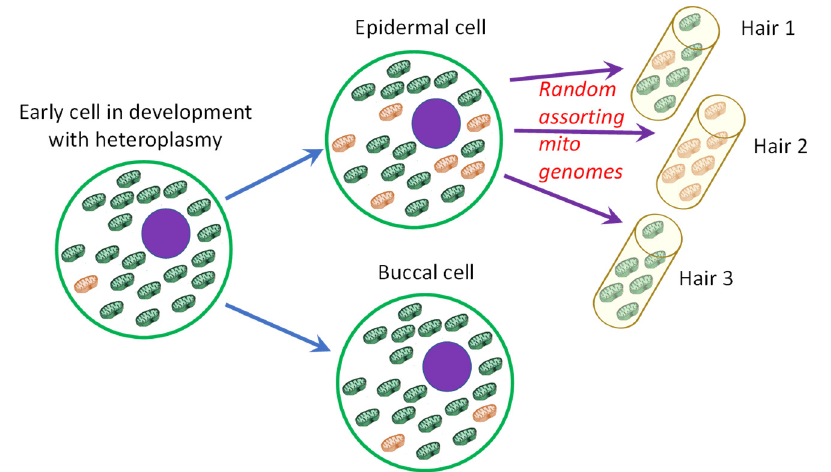
Figure 1. Illustration of shifts in heteroplasmy (HP) levels. Levels of HP can change during development. Especially for hairs, random assorting of mitochondrial genomes can lead to large shifts in HP levels. Once the HP level in the buccal cells is below the detection threshold of the analysis method, this may lead to an (apparent) homoplasmic mismatch with hair 2.